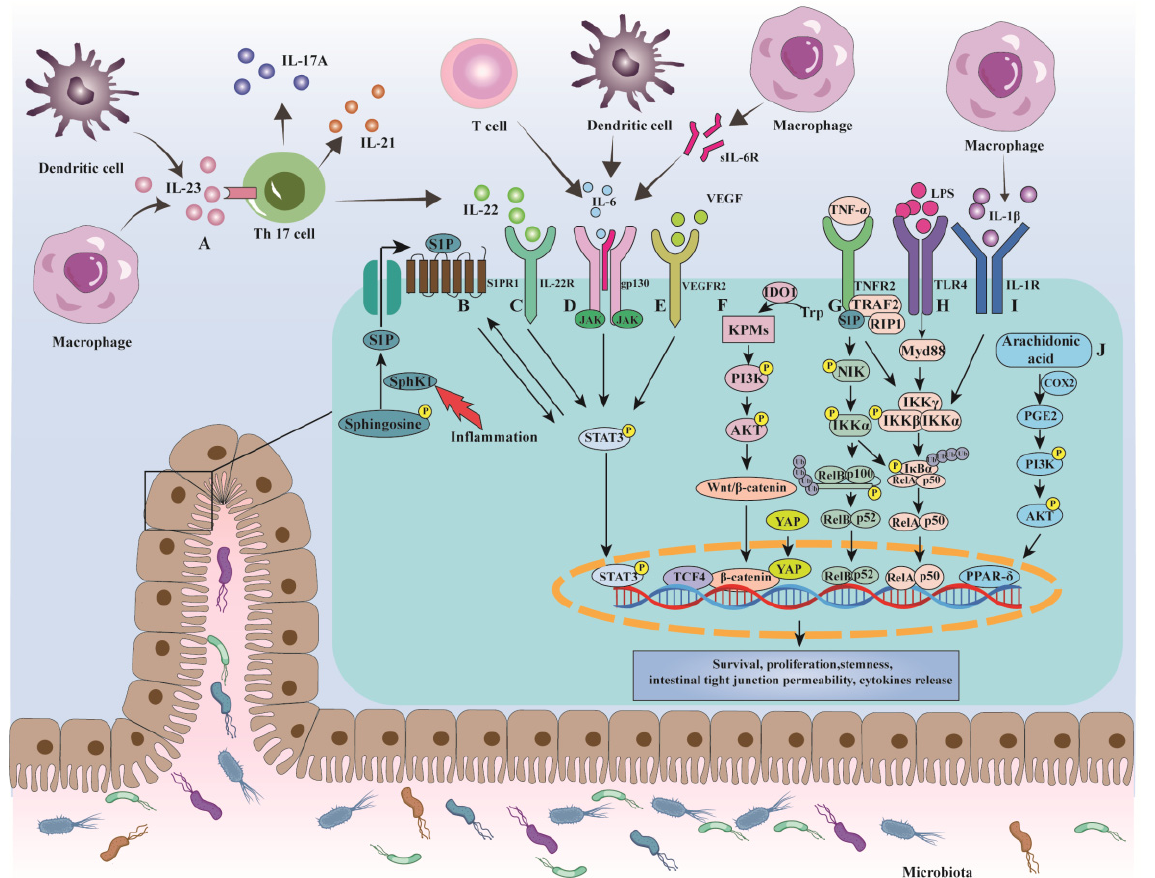
Figure 1. The involvement of cytokine-related signaling pathways in colitis-associated CRC. ( A ) Binding of IL-23 to IL-23R activates the downstream JAK/STAT pathway to release IL-17A, IL-21, IL-22 from Th17 cells, exerting proinflammatory and protumor effects. ( B – E ) Several factors such as S1P, IL-22, IL-6, VEGF contribute to phosphorylation of STAT3 that upregulates Bcl-x and Caspase 3, downregulate Bcl-xl to inhibit apoptosis. ( F ) Kynurenine pathway metabolites rapidly activate PI3K/AKT signaling which then promotes β -catenin translocate to the nucleus, where β -catenin can form transcription complex with YAP and TCF4. ( G – I ) Proinflammatory stimuli including TNF- α , IL-1 β and LPS can participate in tumor initiation and development through boosting the down- stream molecule NF- κ B activity. ( J ) PGE2 activates PI3K/AKT/PPAR- δ signaling to promote cell